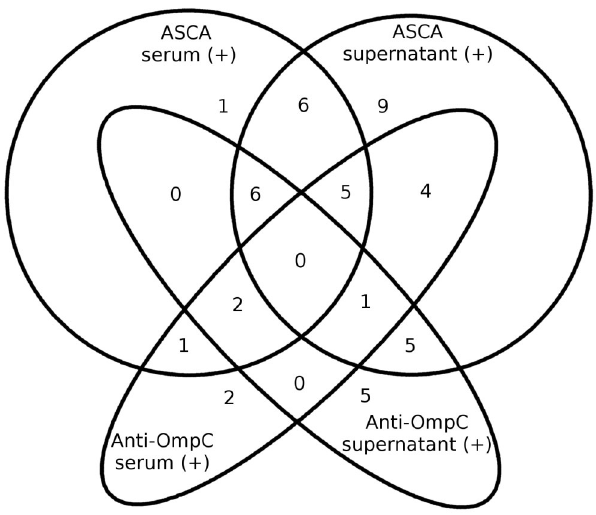
Figure 2. Profile of ASCA and anti-OmpC antibodies in sera/ supernatants of the 47 CD patients displaying at least one positive test. ASCA: anti- Saccharomyces cerevisiae antibodies, anti- OmpC: anti-outer membrane porine C antibodies.